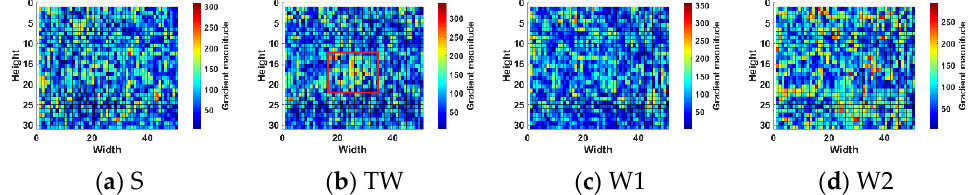
Figure 3. Distribution figure of gradient values. ( a ) Sky area; ( b) dim point target area; ( c ) sea clutter area W1; ( d ) sea clutter area W2.